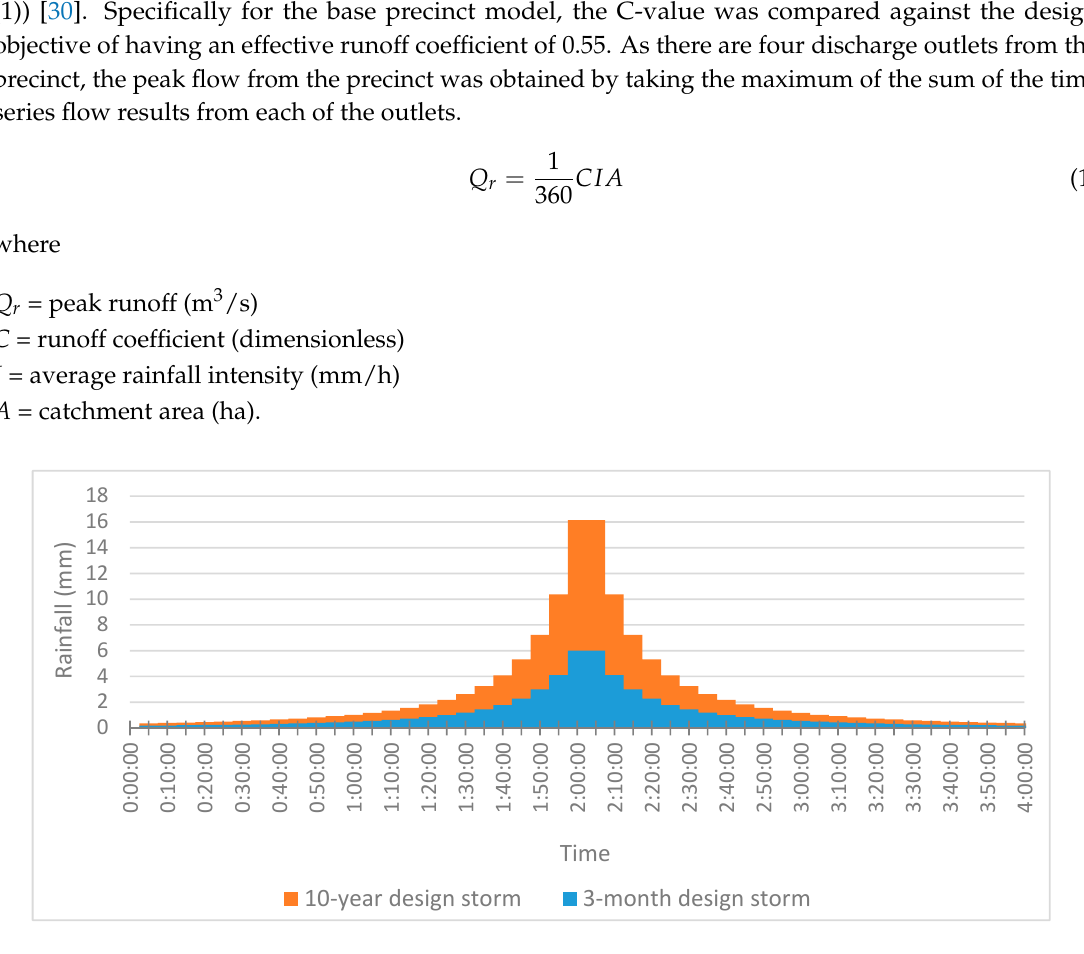
Figure 9. Rainfall hyetographs for the 10-year and 3-month design storms in Singapore [7,31].